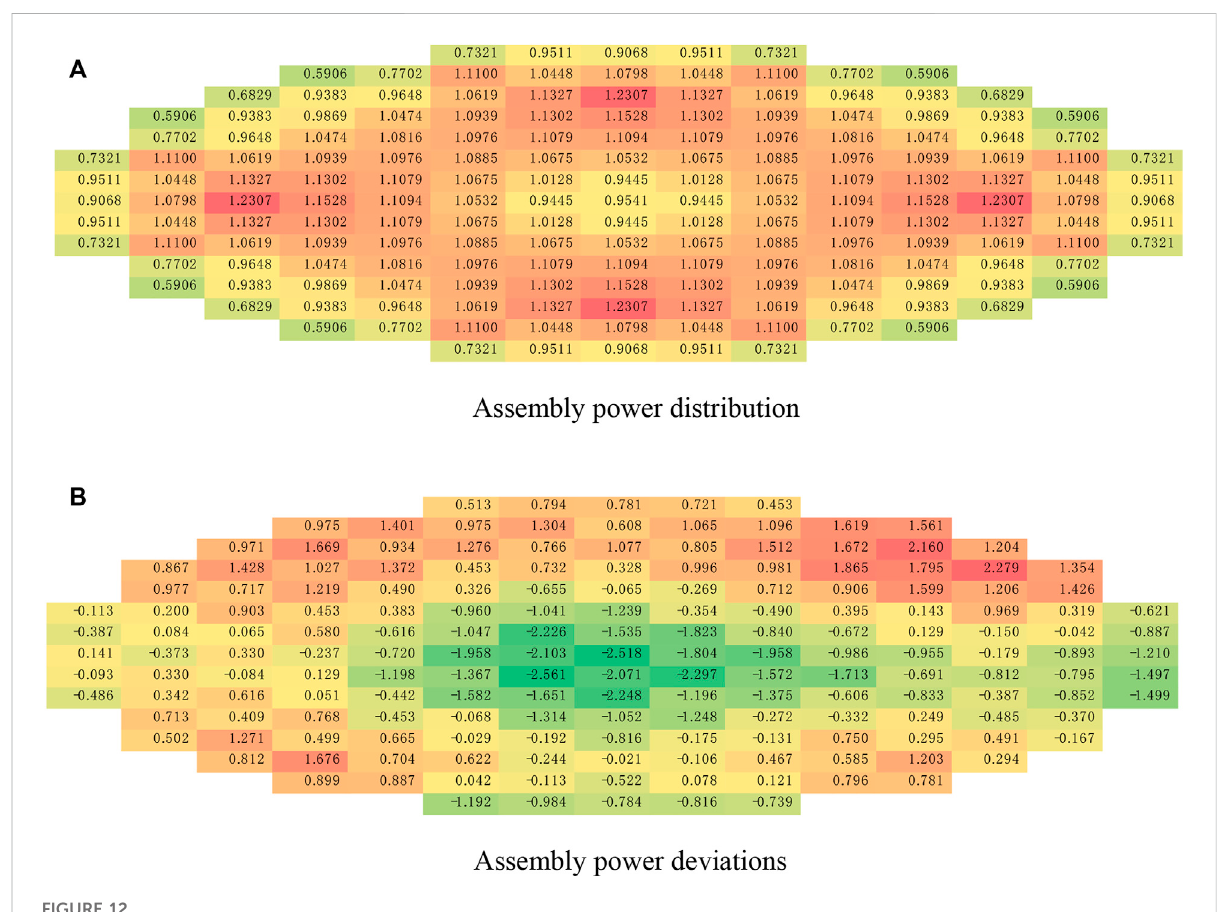
FIGURE 12 Assembly power distribution and deviations in advanced PWR whole-core